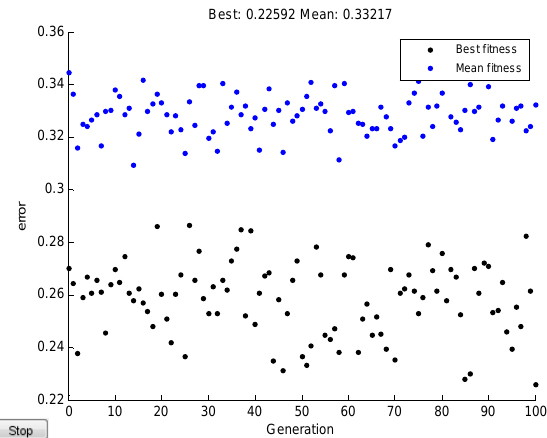
Fig 12(a) Performance of GA for Cars data set Fig 12(b) Performance of Selectively Cloned GA for Cars data set